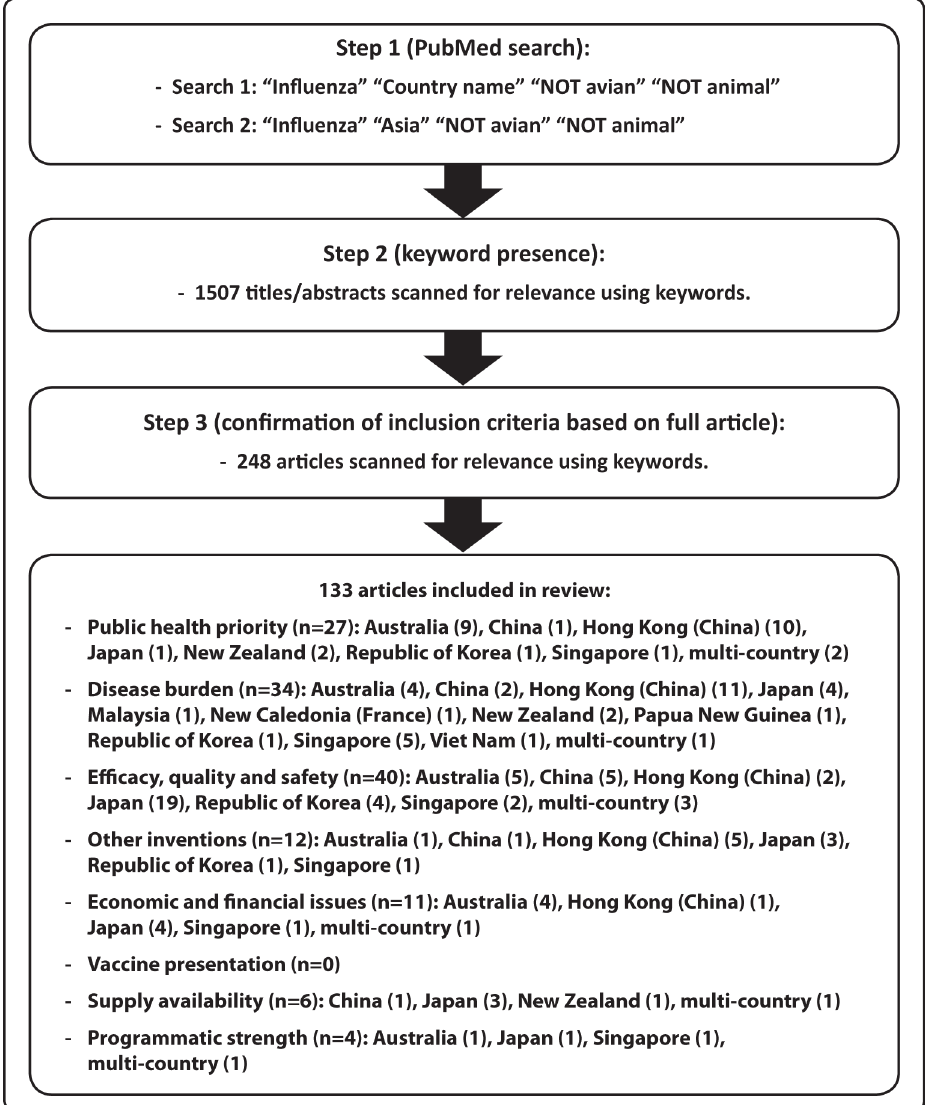
Figure 2. Methods to identify studies included in the literature review.